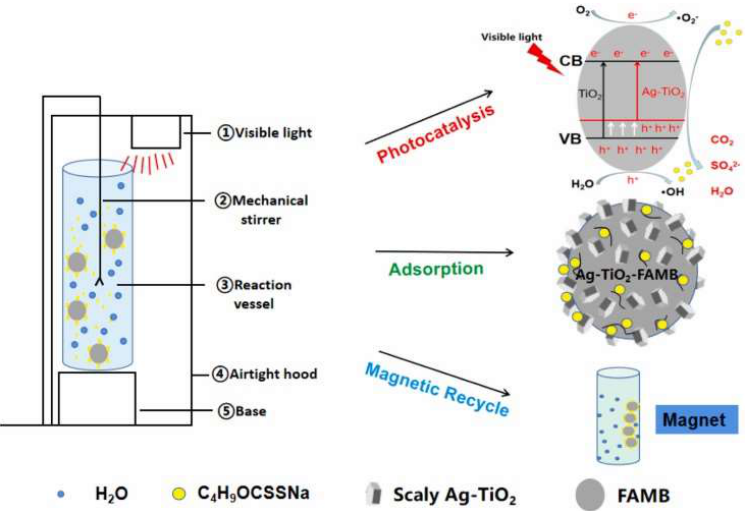
Figure 5. Xanthate degradation mechanism diagram (Reproduced from Colloids Surf. Physicochem. Eng. Aspects 2021, 624 with permission from Elsevier) [14].